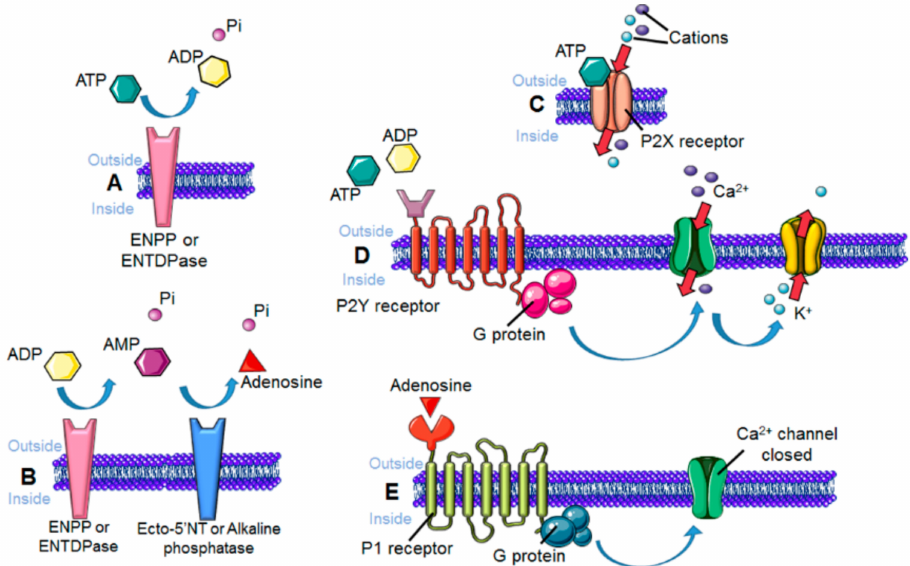
Figure 5. Mechanism of activation of purinergic receptors. ( A ) Extracellular ATP is hydrolyzed to ADP by the action of ectonucleotide pyrophophatase / phosphodiesterases (ENPPs) or ectonucleoside triphosphate dyphosphohydrolases (ENTDPases). ( B ) ADP is subsequently hydrolyzed to AMP, also by ENPPs and ENTDPases. AMP is converted to adenosine by ecto-5 (cid:48) -nucleotidases (Ecto-5 (cid:48) -NTs) or alkaline phosphatases. ( C ) P2X cation-permeable ionotropic receptors are activated by nucleosides triphosphate. ( D ) G protein-coupled P2Y receptors regulate voltage-gated Ca 2 + and K + channels. ( E ) Adenosine-mediated P1 receptor activation results in blockade of Ca 2 +